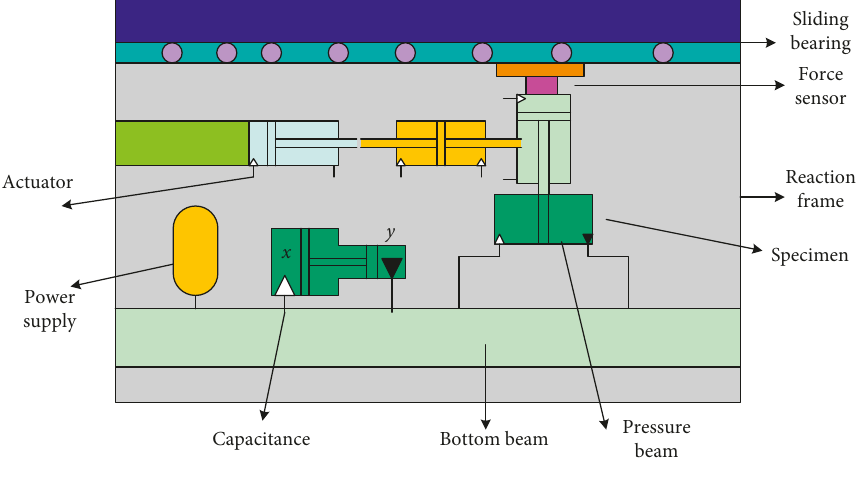
Figure 2: Loading